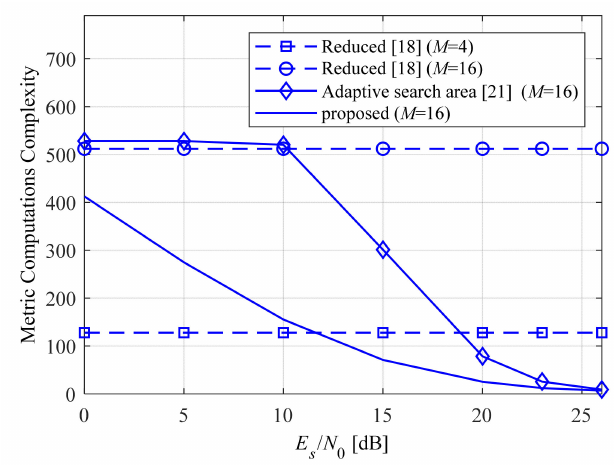
Figure 12. Average metric computation complexity comparisons, N = L = 4 with 16 QAM.